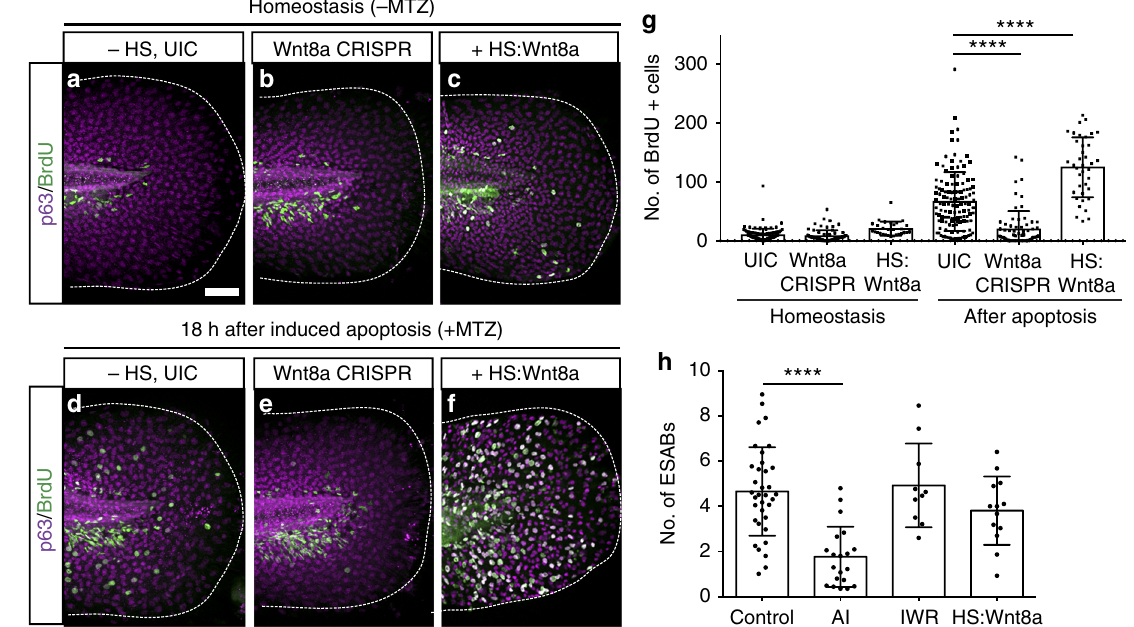
Fig. 4 ESAB (epithelial stem cell-derived apoptotic body)-delivered Wnt8a is required for apoptosis-induced stem cell division. a – f Maximum intensity projections of confocal images for bromodeoxyuridine (BrdU) (green) and p63 (magenta) after perturbation of Wnt8a signaling ( a – c ), and in combination with induction of apoptosis ( d – f ) (scale = 50 µ m). g Mean number of BrdU-positive cells from individual larvae after perturbation of Wnt8a ( n = 9) and in combination with induced apoptosis ( n = 10). h Quantitative analysis of ESAB production from controls ( n = 35) and after treatment with apoptosis inhibitor (AI) ( n = 20), the Wnt inhibitor IWR ( n = 10) or overexpression of Wnt8a ( n = 13). Data are represented as mean ± sd; **** p < 0.0001. One-way analysis of variance (ANOVA) with Dunnett ’ s mutiple comparisons test ( g , h